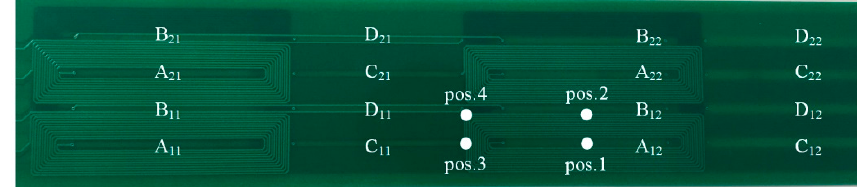
Figure 21. ( a ) Experimental waveforms. ( b ) Snapshot from power analyzer.